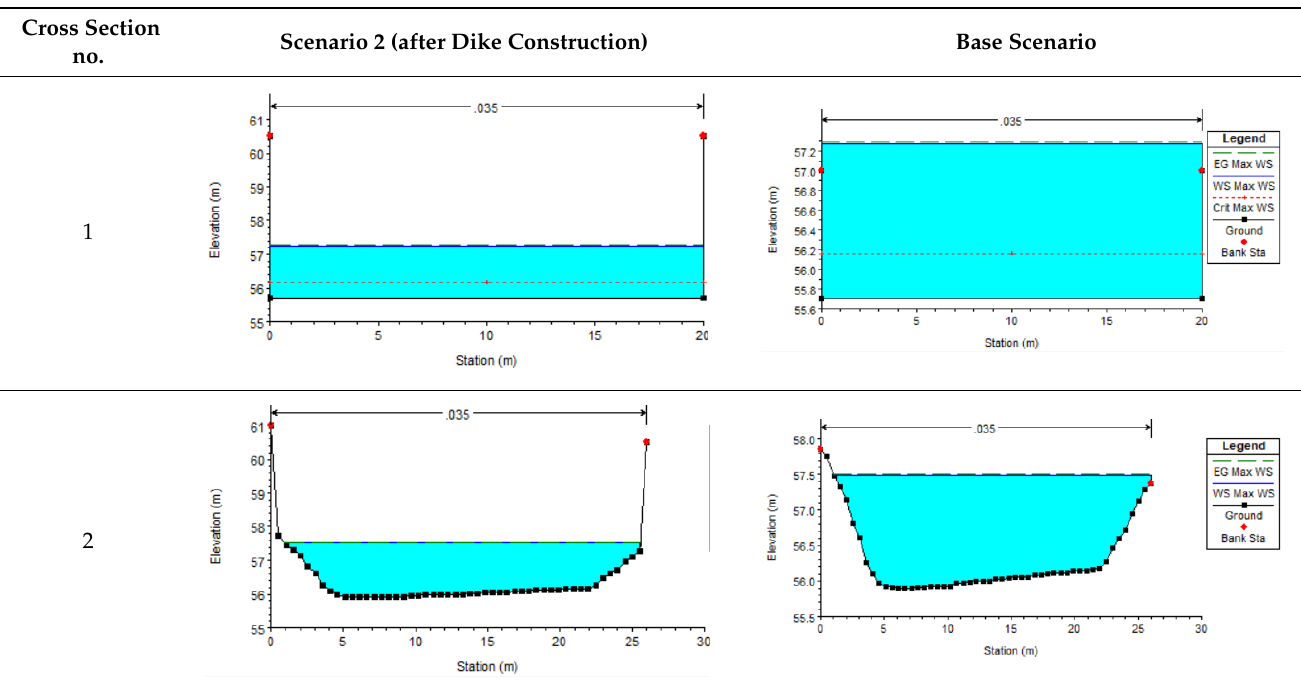
Table 8. Comparison of water stage between the base scenario and after-dike-construction scenario for different cross